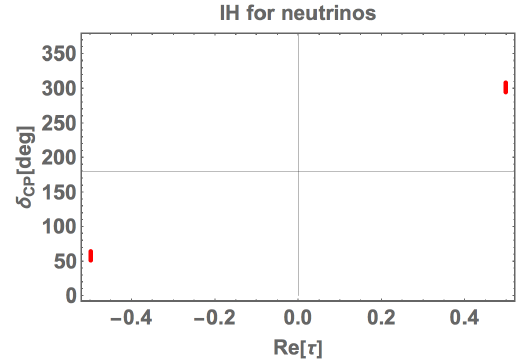
Figure 5 . Allowed regions of τ for IH at p χ 2 = 4 – 5 .